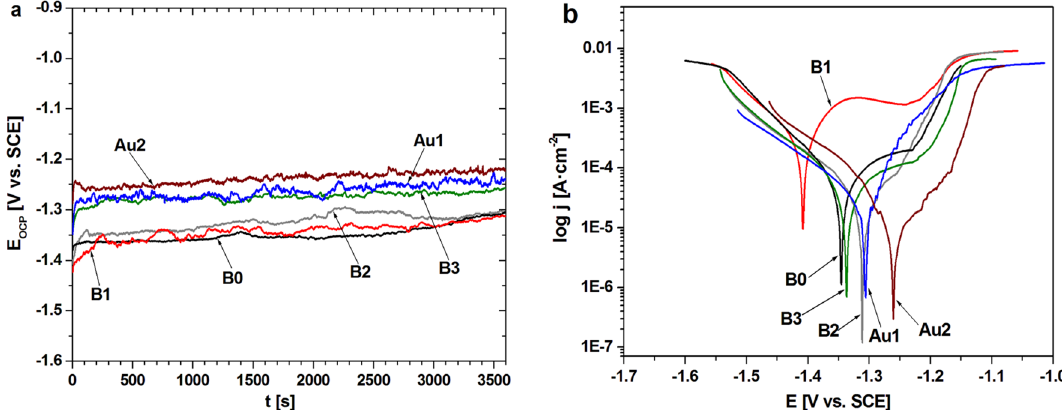
Figure 4. Changes of open-circuit potential with time ( a ) and polarization curves ( b ) of CaMgZnYbBAu alloys in a form of plates in Ringer’s solution at 37 °C 22–24